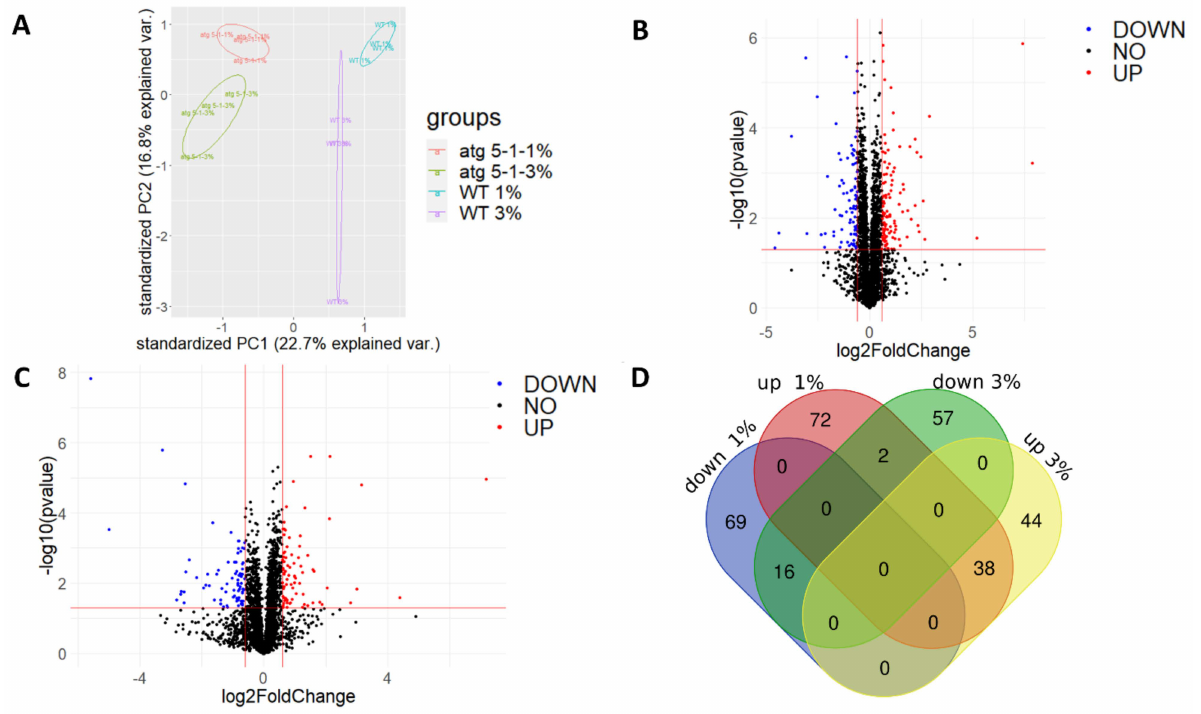
Figure 6. Proteomic analysis of roots revealed differences in protein levels during sucrose excess and between WT and atg5-1 plants. WT and atg5-1 were sown on Nitsch plates containing 1% or 3% sucrose and grown vertically for 10 days. Roots were then collected and subjected to proteomic analysis by liquid chromatography with tandem mass spectrometry (LC-MS/MS). ( A ) PCA of the label-free quantification (LFQ) values of the entire proteome. ( B ) Volcano plot for 1% sucrose— p values and fold-change relative to atg5-1 . ( C ) Volcano plot for 3% sucrose— p values and fold-change relative to atg5-1 . ( D ) Venn diagram of differentially accumulated proteins: http://bioinformatics. psb.ugent.be/webtools/Venn/, accessed on 26 December